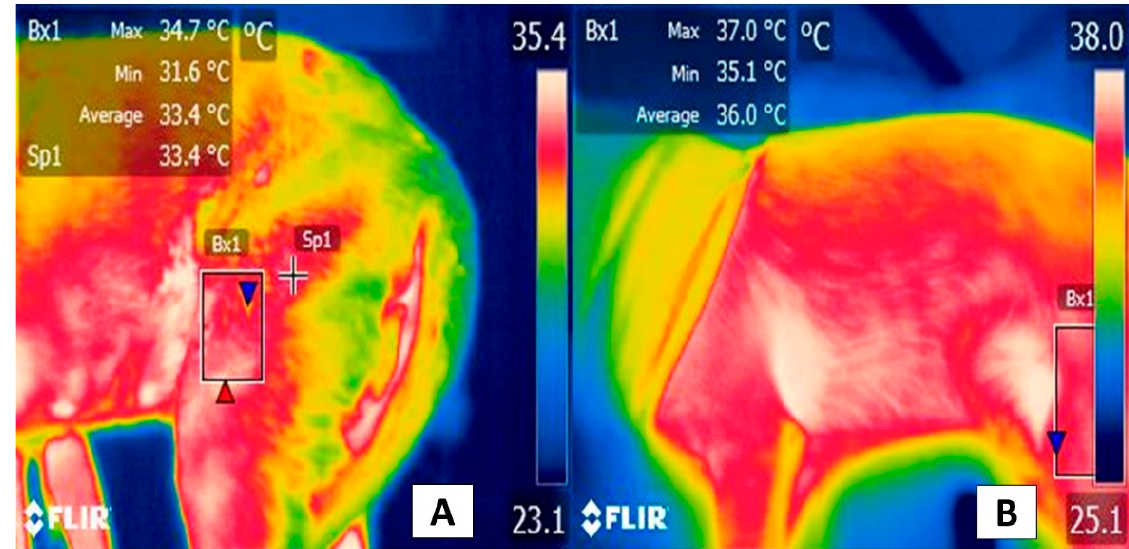
Figure 6. Thermal response of the femoral biceps muscle during moderate exercise. The thermal window of the femoral biceps muscle has been proposed to determine dogs’ thermal state during exercise. This muscle spans the lateral face of the cranial zone of the femoral region, from the middle third of the femur to the proximal level of the distal epiphysis, 3 mm from the tibia-femoral-patellar joint. This zone extends to the head surface of the femoral biceps that, finally, has a tendinous insertion into the tibial tuberosity, represented by the rectangle (Bx1). ( A ) Thermal response of the femoral biceps muscle prior to exercise. This image shows the thermal response of the femoral biceps muscle (Bx1) with maximum and minimum temperatures of 34.7 °C (red triangle) and 31.6 °C (blue triangle) in a 3- year-old, non-breed female at rest. ( B ) Thermal response of the femoral biceps muscle after moderate exercise. The image shows the thermographic response after 15 min of moderate exercise during a clinical assessment of the dog’s march. The significant increases of 2.3 °C (red triangle) and 3.5 °C (blue triangle) in the maximum and minimum temperatures stand out. It is suggested that this response is due to the increase in dogs’ central temperature during physical activity, and hence the femoral biceps muscle receives significant vascularization from the femoral artery. Sp1: default focal point of the software. Thermal images obtained using a FLIR thermal camera.